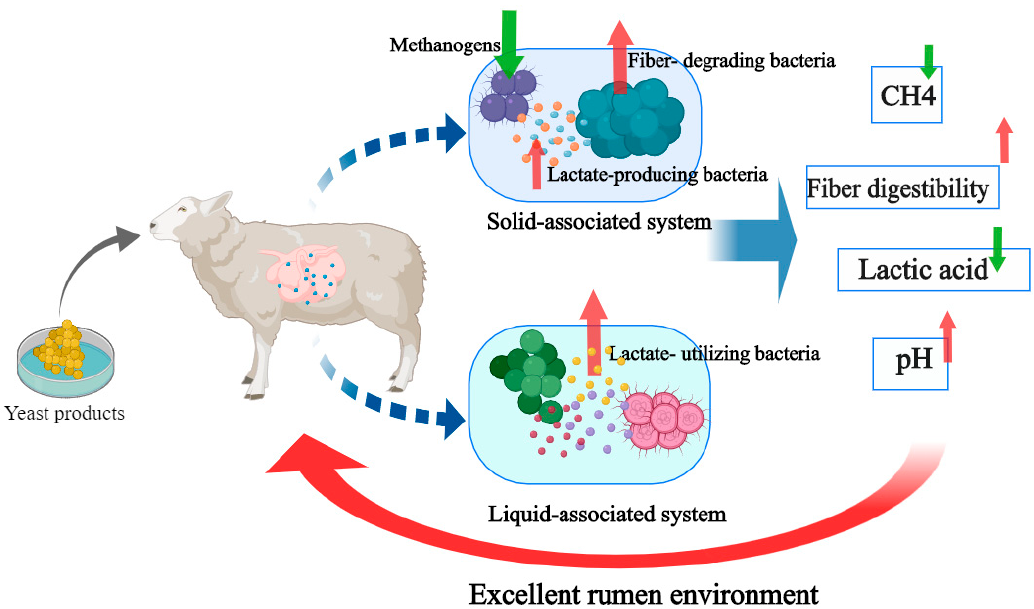
Figure 5. Yeast product regulates rumen fermentation by changing rumen microorganisms.